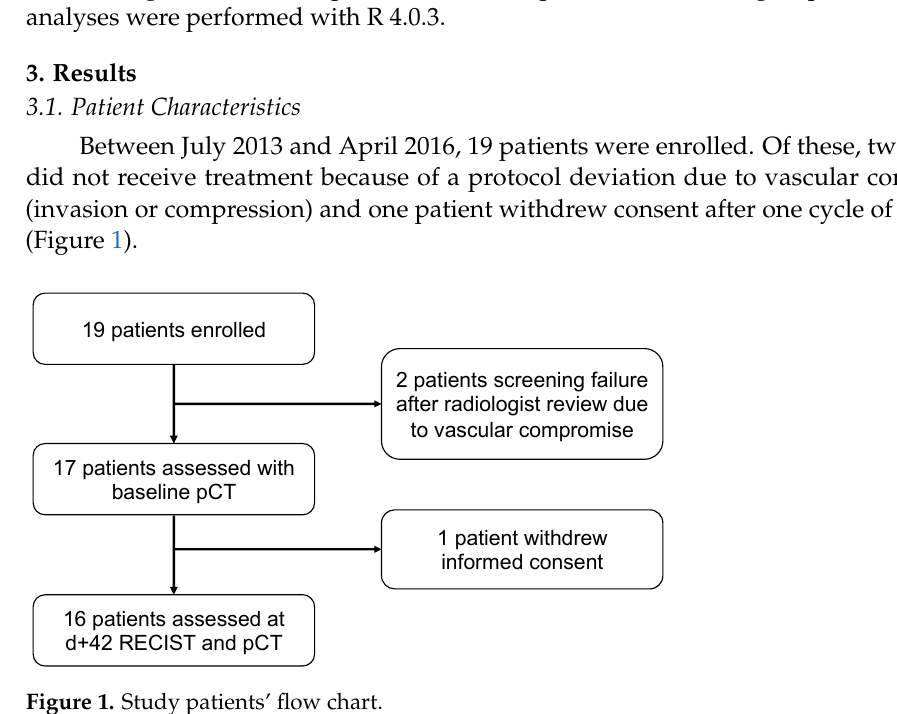
Figure 1. Study patients’ flow chart.